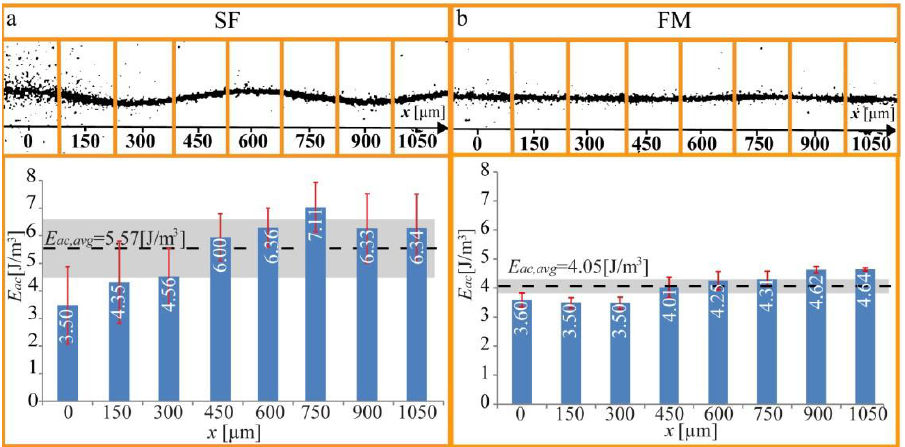
Figure 6. Measurement of the spatial distribution of the acoustic energy density along a micro-channel ( x -axis), when actuating the chip with ( a ) Single-frequency (SF) actuation; and ( b ) Frequency-modulation (FM) actuation. The light-intensity method was applied to eight 150 μ m wide subsections of the recorded images. The averaged energy density for the , is marked with a dotted black line, and the corresponding 1 σ standard whole channel, E ac,avg deviation is marked with a grey band. The red error bars are the standard deviations from the four repetitions of each experiment. The figure is reproduced from Ref. [28] by permission from IOP